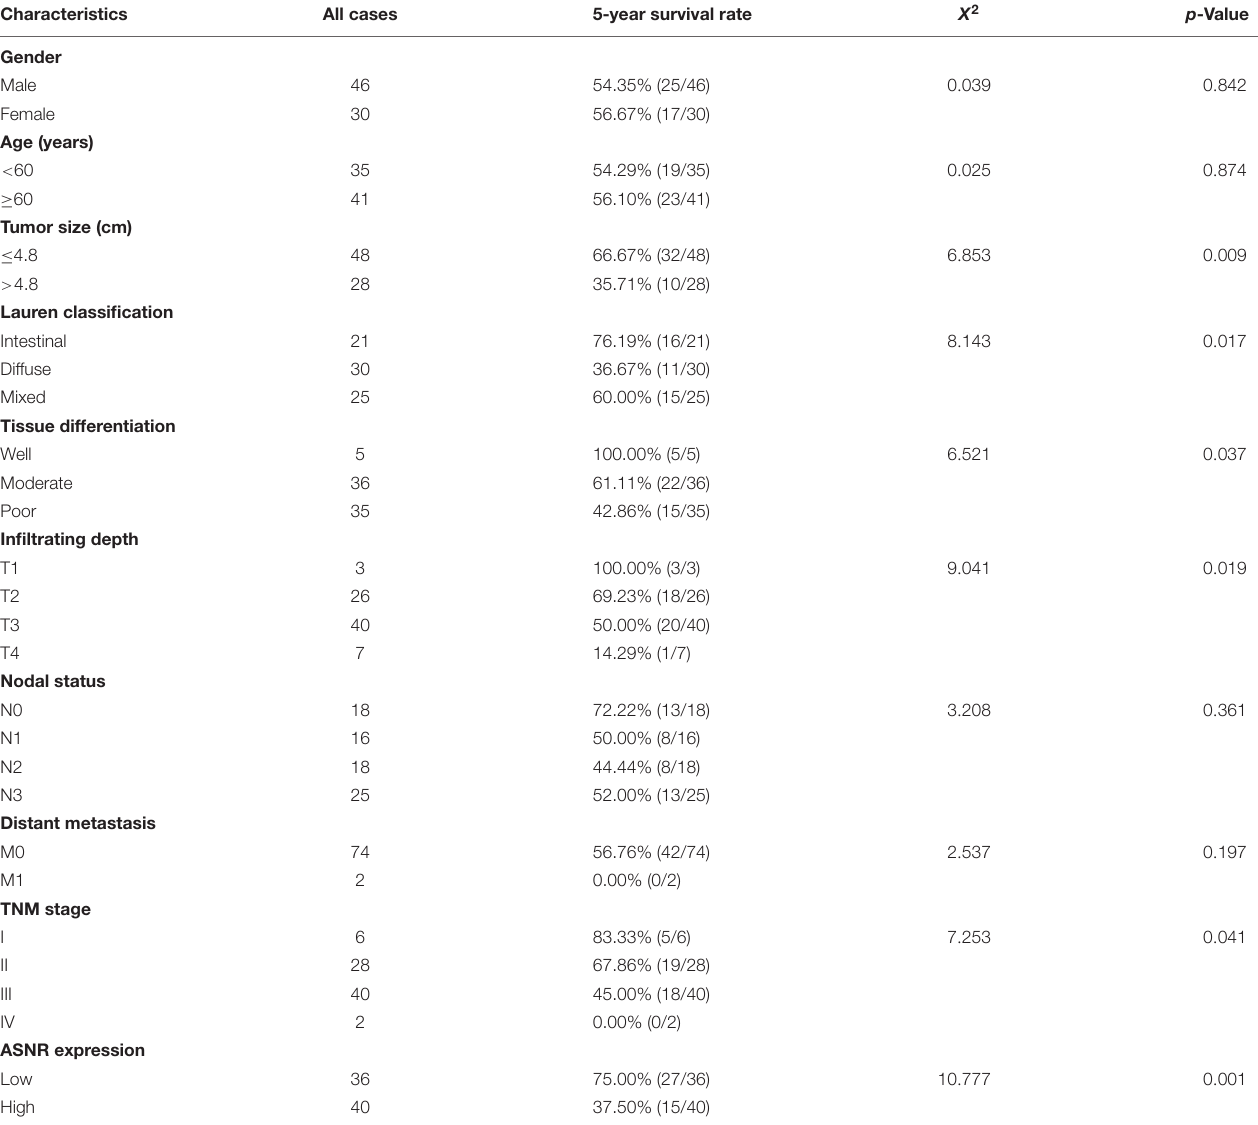
TABLE 2 | Univariate analysis of prognostic factors in 76 patients with gastric cancer.